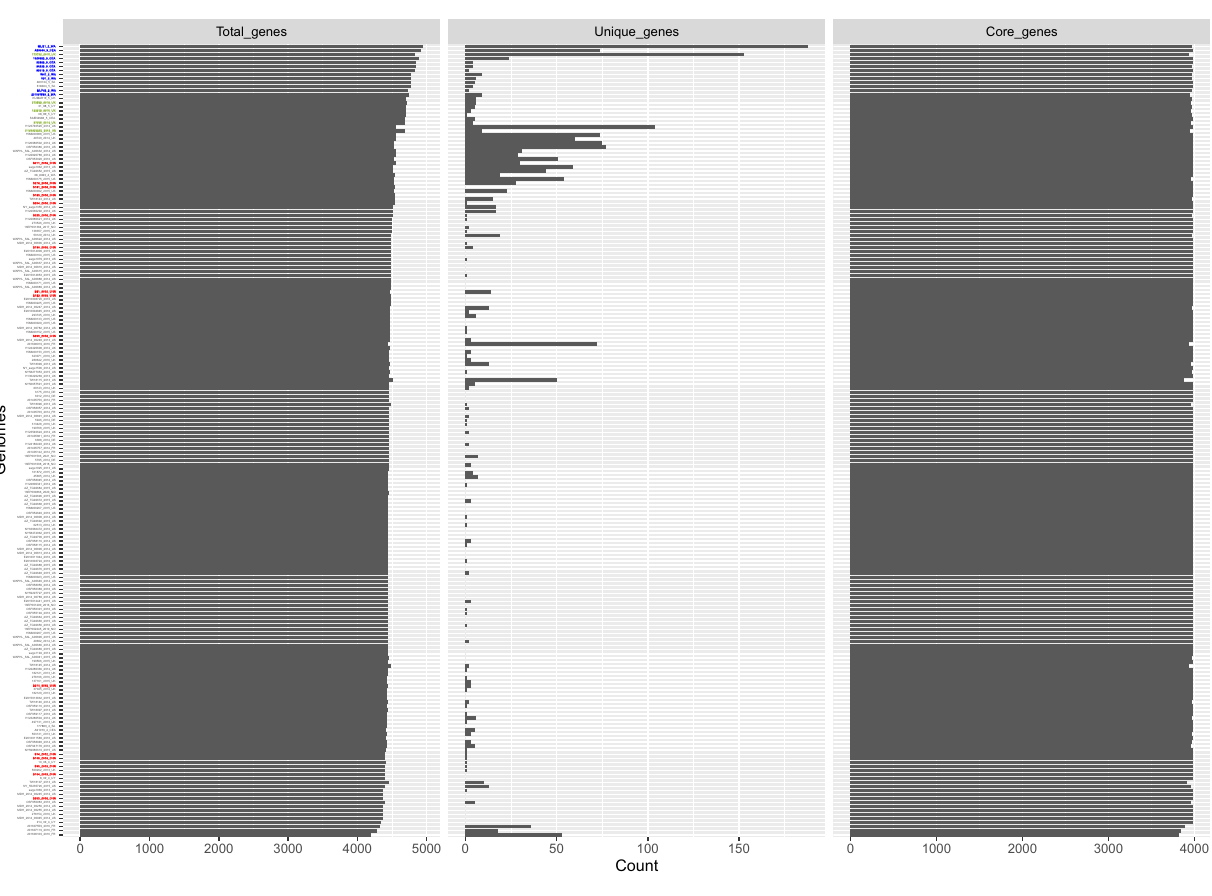
Figure 4. Plot of number of genes, unique genes, and core genes per genome among the 197 S . Enteritidis